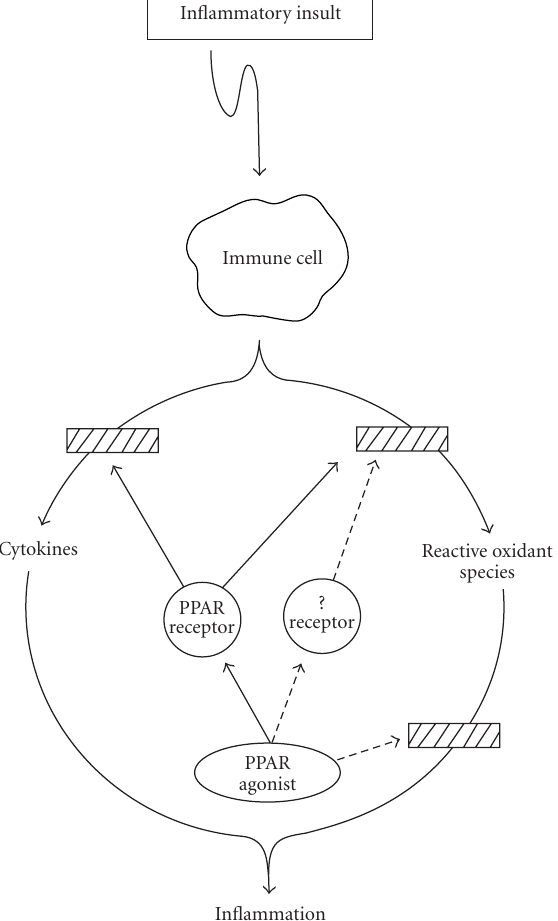
Figure 3. A scheme depicting potential mechanisms via which anti-inflammatory e ff ects are exerted by PPAR agonists. Solid lines represent potential PPAR-mediated e ff ects. Dashed lines represent proposed mechanisms by which PPAR agonists may act via PPAR-independent mechanisms to diminish inflamma-